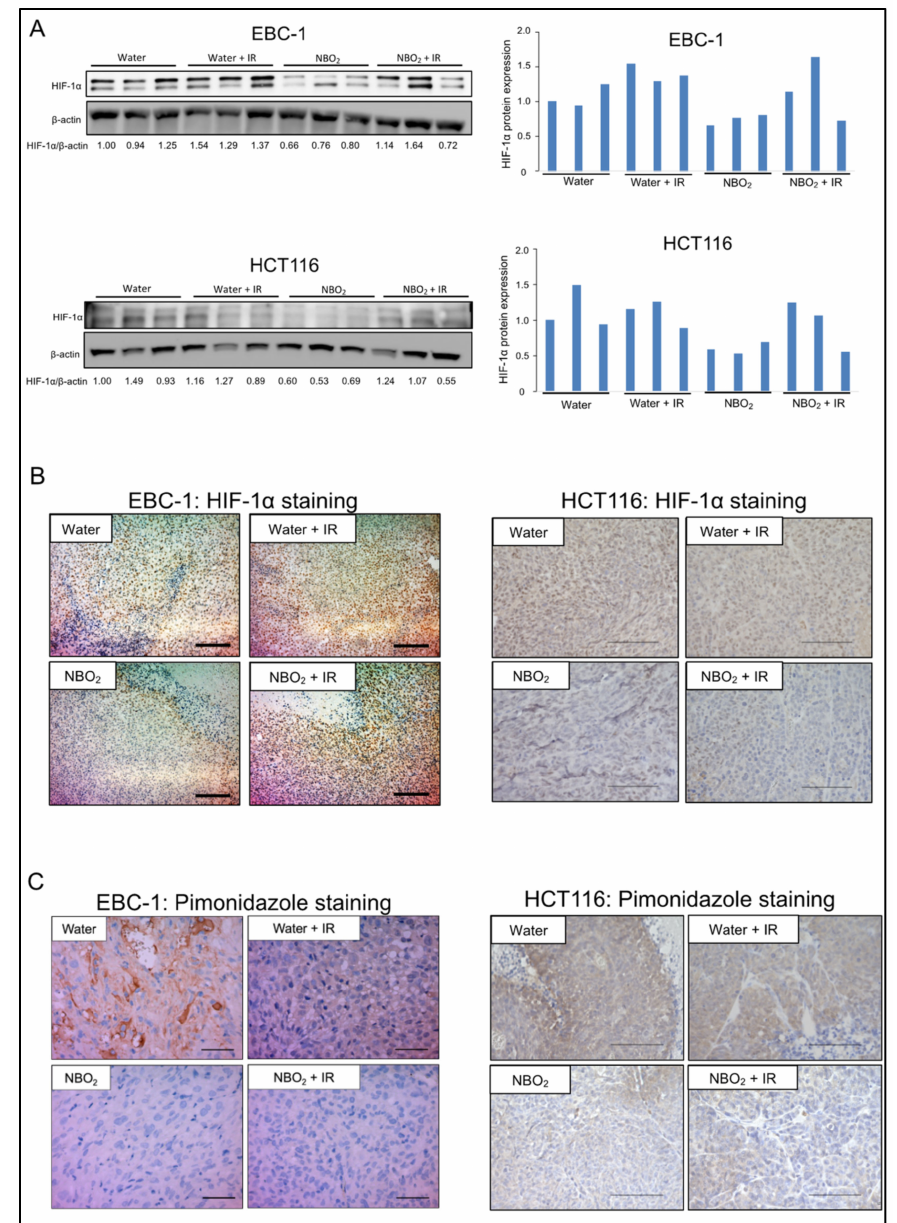
Figure 5. Suppression effect of HIF-1 α and hypoxic condition by NBO 2 water in EBC-1 and HCT116 xenografted tumors. ( A ) Protein expression of HIF-1 α in EBC-1 tumor xenografts of each group detected by Western blotting. These proteins were normalized to the level of β -actin expression. Intensity was measured using Image J software. ( B ) Representative immunohistochemical staining of HIF-1 α in EBC-1 and HCT116 xenografted tumors of each group (EBC-1, scale bar 200 µ m; HCT116, scale bar 100 µ m). ( C ) Histological section of pimonidazole staining in EBC-1 and HCT116 xenografted tumors of each group in 28 days (EBC-1, scale bar 50 µ m; HCT116, scale bar 100 µ m). To validate the hypoxia-related signal alteration in each group, we evaluated the im- munohistochemical staining of carbonic anhydrase IX (CA IX) as a representative hypoxia- related downstream pathway regarding radiation resistance in cancer cells [16]. As a result, the expression levels of CA IX in the NBO 2 water and NBO 2 + IR groups were lower than those in the other groups (Figure